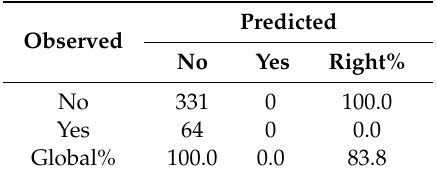
Table 11. Classification success for using Twitter.